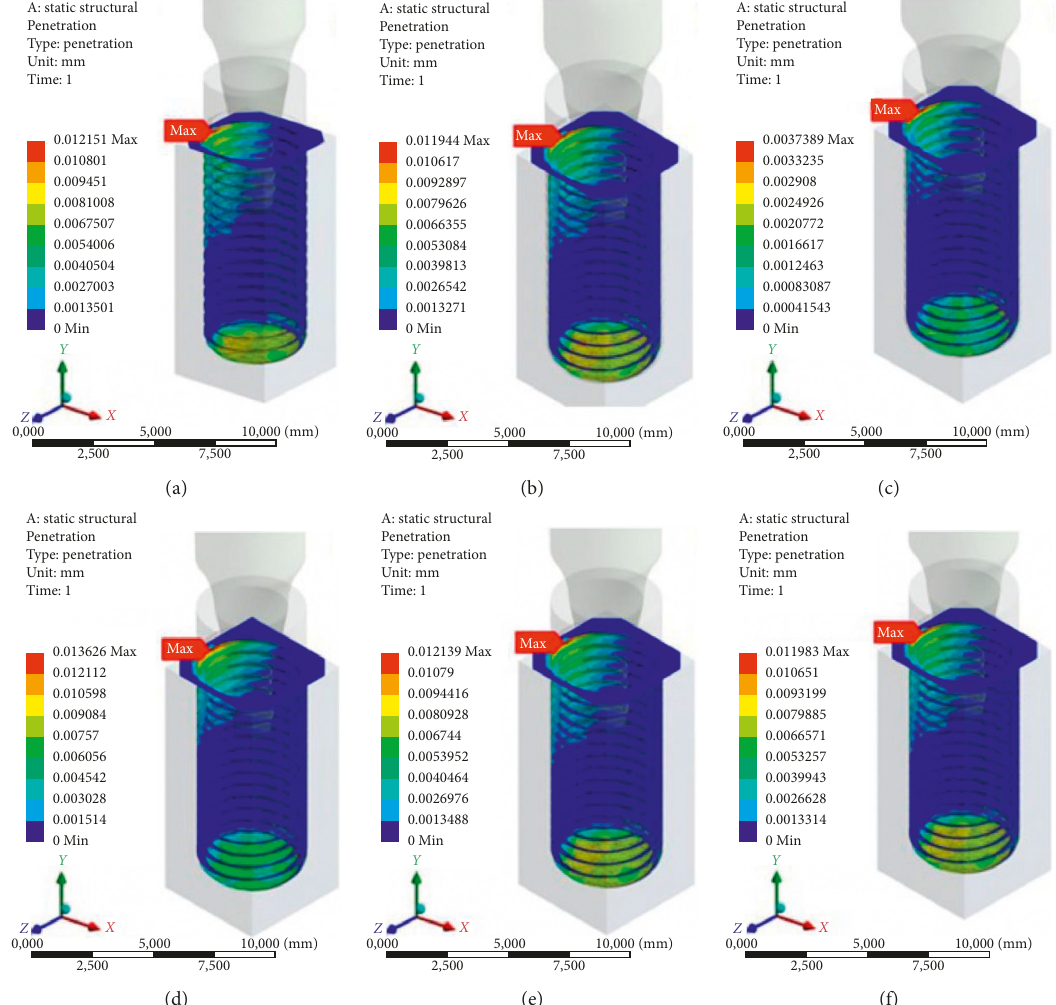
Figure 4: Bone penetration results of implants. Implant materials are AISI 316L stainless steel (a), nanoporous anodic alumina (b), L-605 CoCr alloy (c), cp Ti with the nanotubular TiO 2 surface (d), YSZ (e), and ZTA